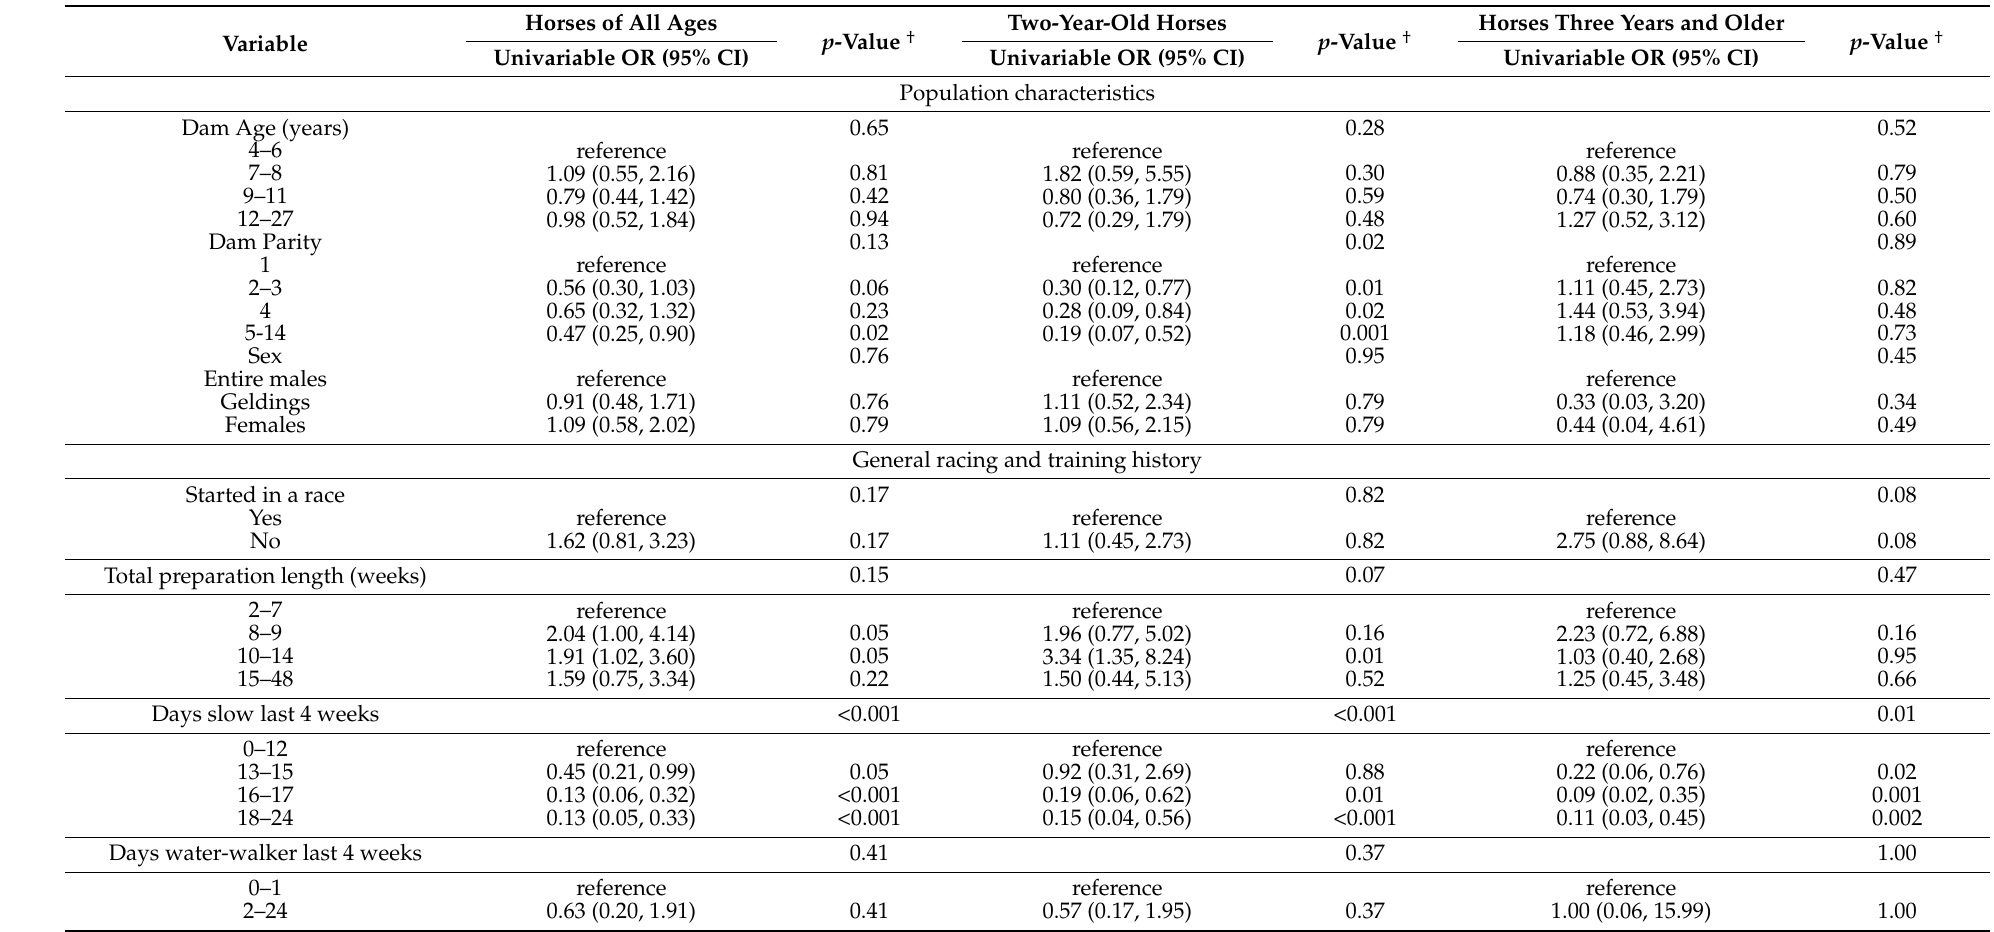
Table 2. The effect of population characteristics, general racing and training history, high-speed exercise history, and racing and performance indices on musculoskeletal injuries in Thoroughbred racehorses in South-East Queensland,